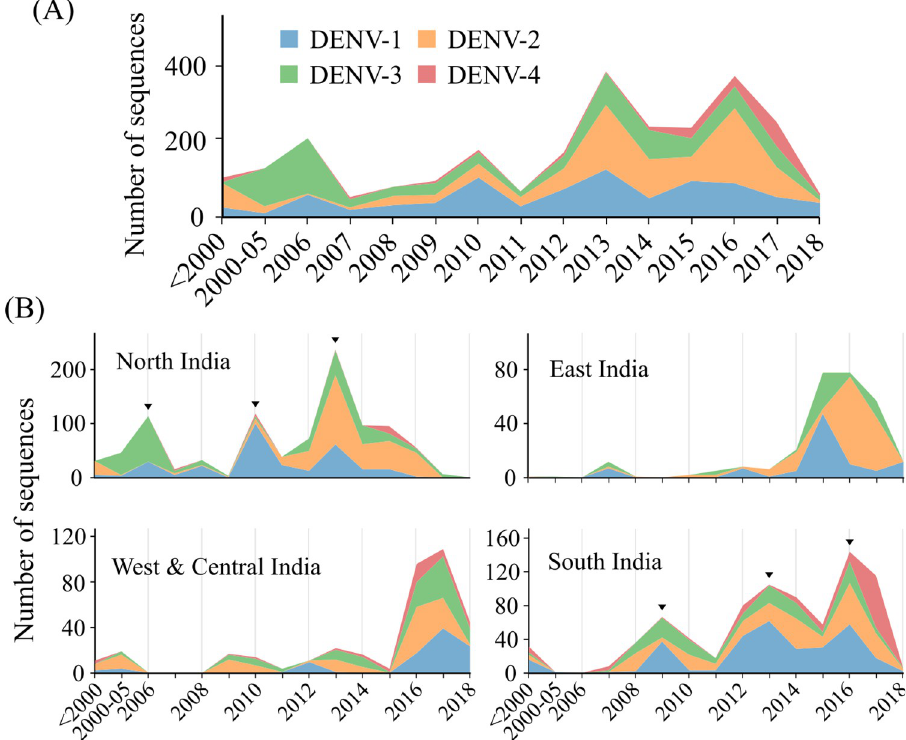
Fig 1. Year-wise dengue sequences reported from India. (A) Dengue serotype sequences available from India till 2018. (B) Distribution of dengue serotypes in different regions of India. DENV-1: blue, DENV-2: orange, DENV-3: green, DENV-4: red. Arrows indicate the peaks in the number of